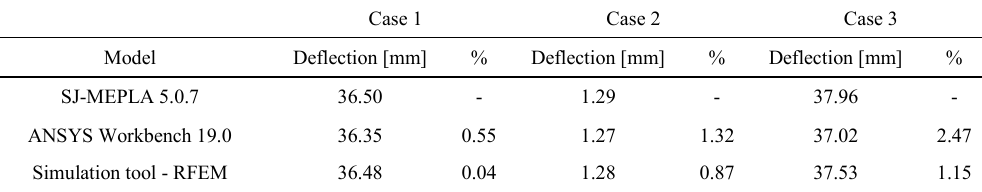
Table 2: Maximum out-of-plane deflection on the inner pane. Flat rectangular